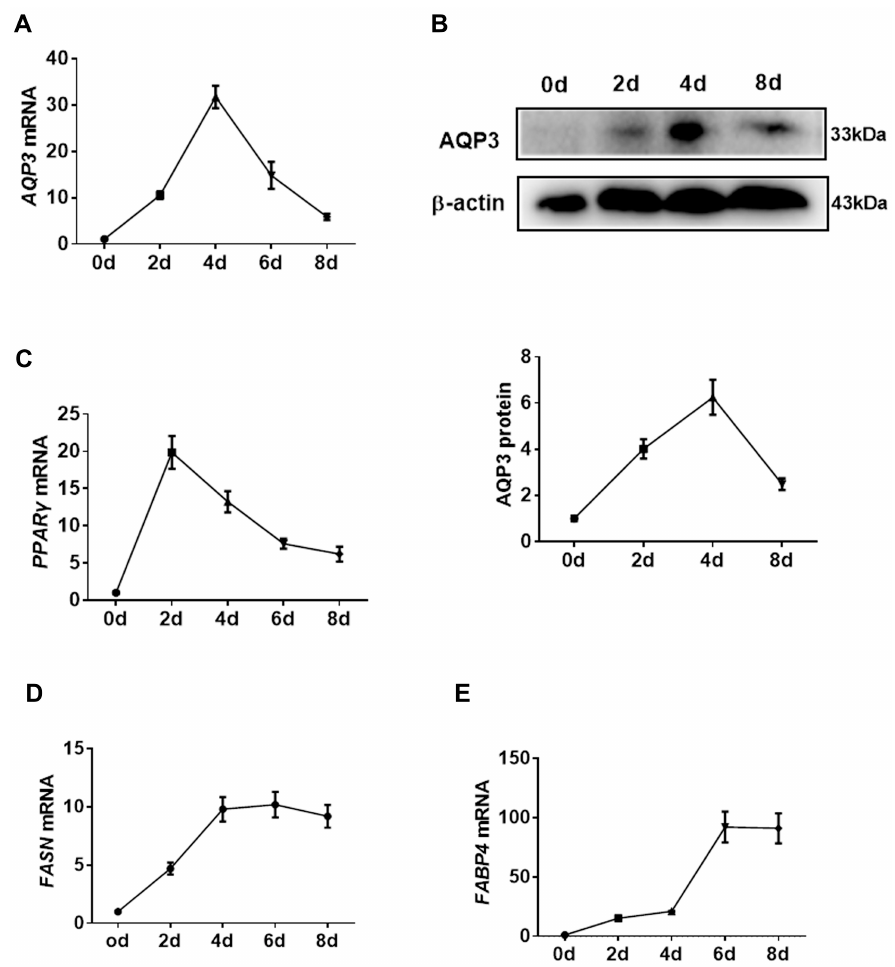
Figure 2. Expression pattern of porcine AQP3 in adipogenesis. The expression of AQP3 during adipogenesis was detected by RT-qPCR ( A ) and Western blot ( B ). The expression of PPAR γ ( C ), FASN ( D ), and aP2 ( E ) was detected by RT-qPCR. β -actin was used as internal reference gene. n = 3.